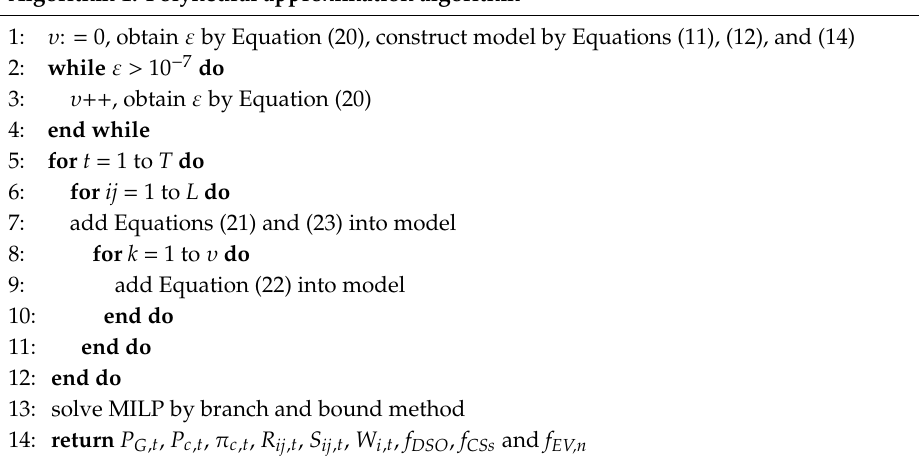
Algorithm 1: Polyhedral approximation algorithm